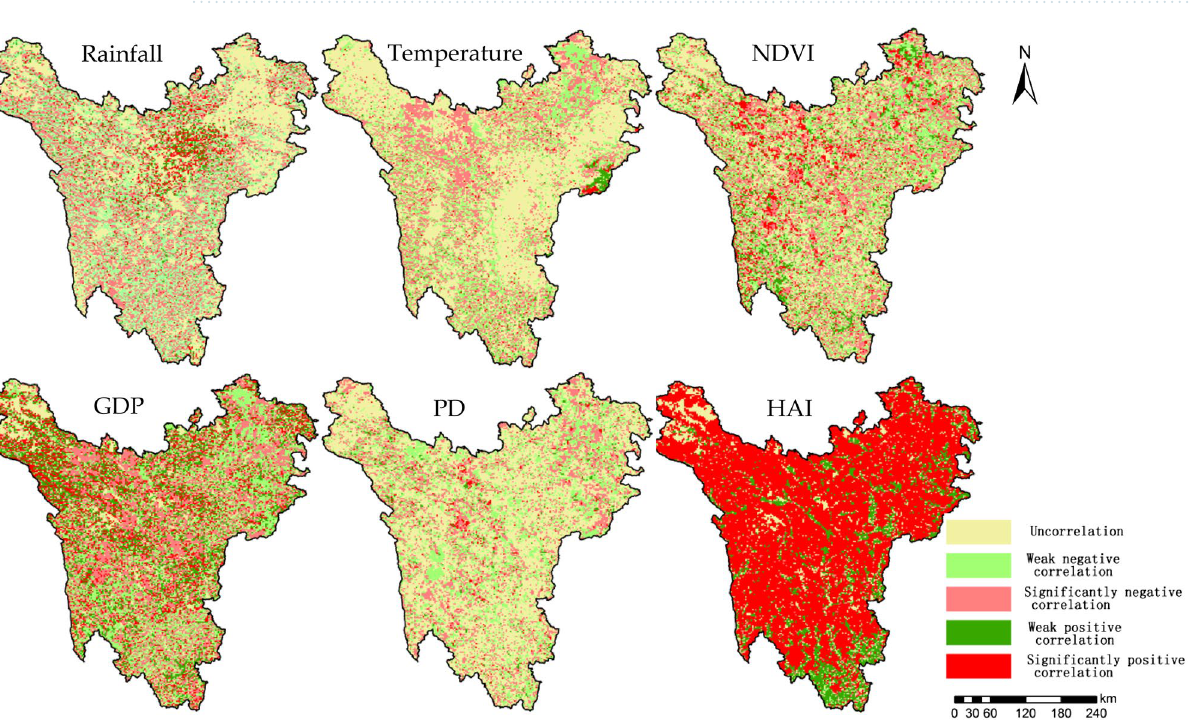
Figure 5. Correlation between carbon storage and impact factors in the study area. Map generated with ArcGIS 10.2